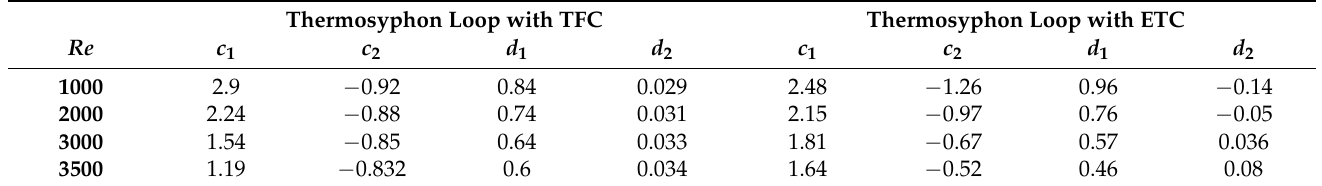
The correlated values of c TFC,ETC and d TFC,ETC in Equations (25) and (26) at the Re of 1000, 2000, 3000, and 3500 are collected in Table 7. Table 7. Correlative coefficients of c 1,2 TFC,ETC and d 1,2 TFC,ETC in the c and d functions. Thermosyphon Loop with TFC Thermosyphon Loop with ETC